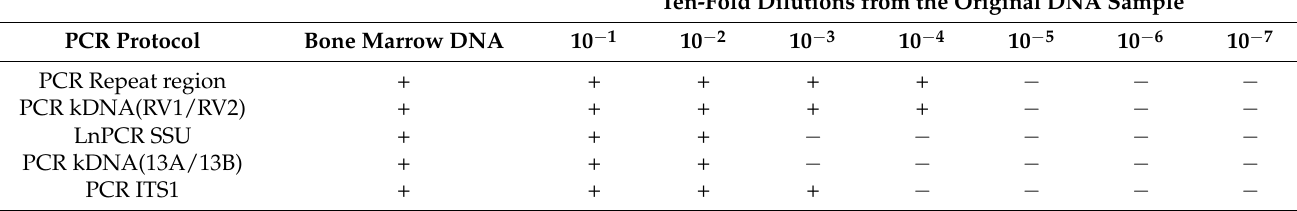
Table 4. PCR amplification from bone marrow DNA of a positive dog using the five PCR protocols employed for detection and identification of L. infantum .